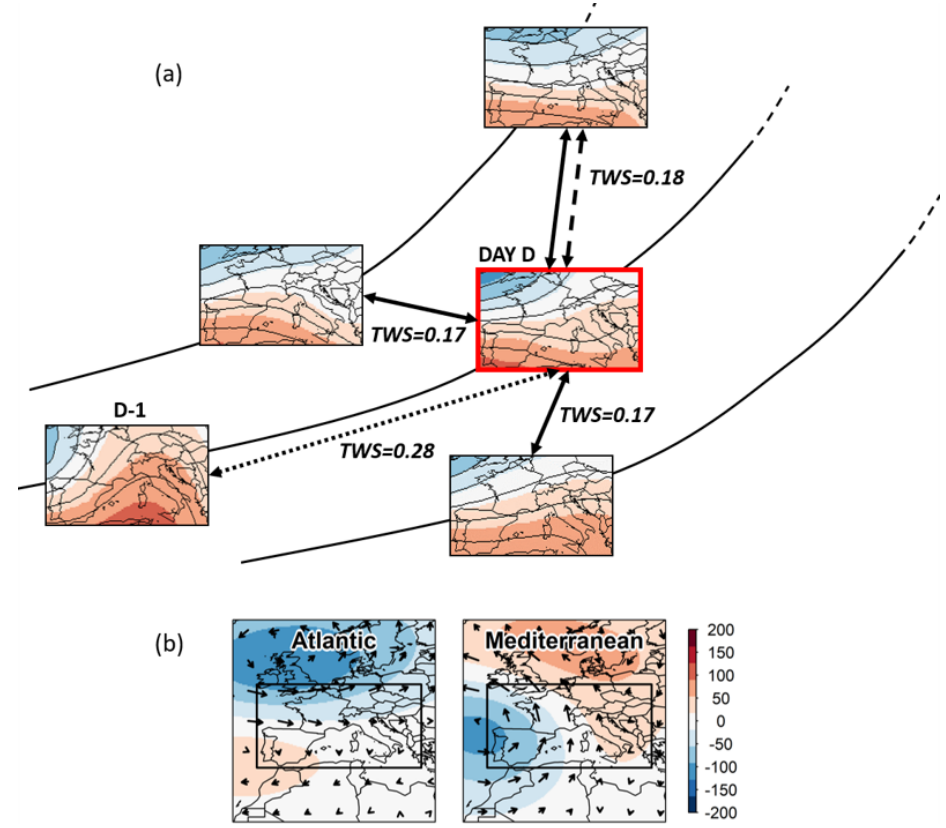
Figure 2. (a) Schematic illustration of the atmospheric descriptors based on analogy. Each map represents the 500hPa geopotential height field over western Europe for a given day. Black lines represent trajectories in phase space. Subsequent days are represented on the same trajectory, but all trajectories are part of a single historical trajectory. The distance between each map represents here the difference in geopotential shapes and/or flow direction between individual days using the Teweles–Wobus score. The scores are represented for indication. The celerity is the distance between a day D and the day before D − 1 (dotted arrow). The singularity is the mean distance between a day D and its closest analogs (solid arrows; 3 analog days for illustration but 111 analog days in our study). The relative singularity is the singularity normalized by the distance to the farthest analog (dashed arrow; 3rd analog day for illustration but 111th analog day in our study). The day D considered here is 12 December 1978. (b) Composite 500hPa geopotential height anomalies (in m) of the Atlantic and Mediterranean influences for the period 1950–2019. The arrows represent the wind anomalies at 500hPa. The black rectangle represents the domain considered for the 500hPa geopotential